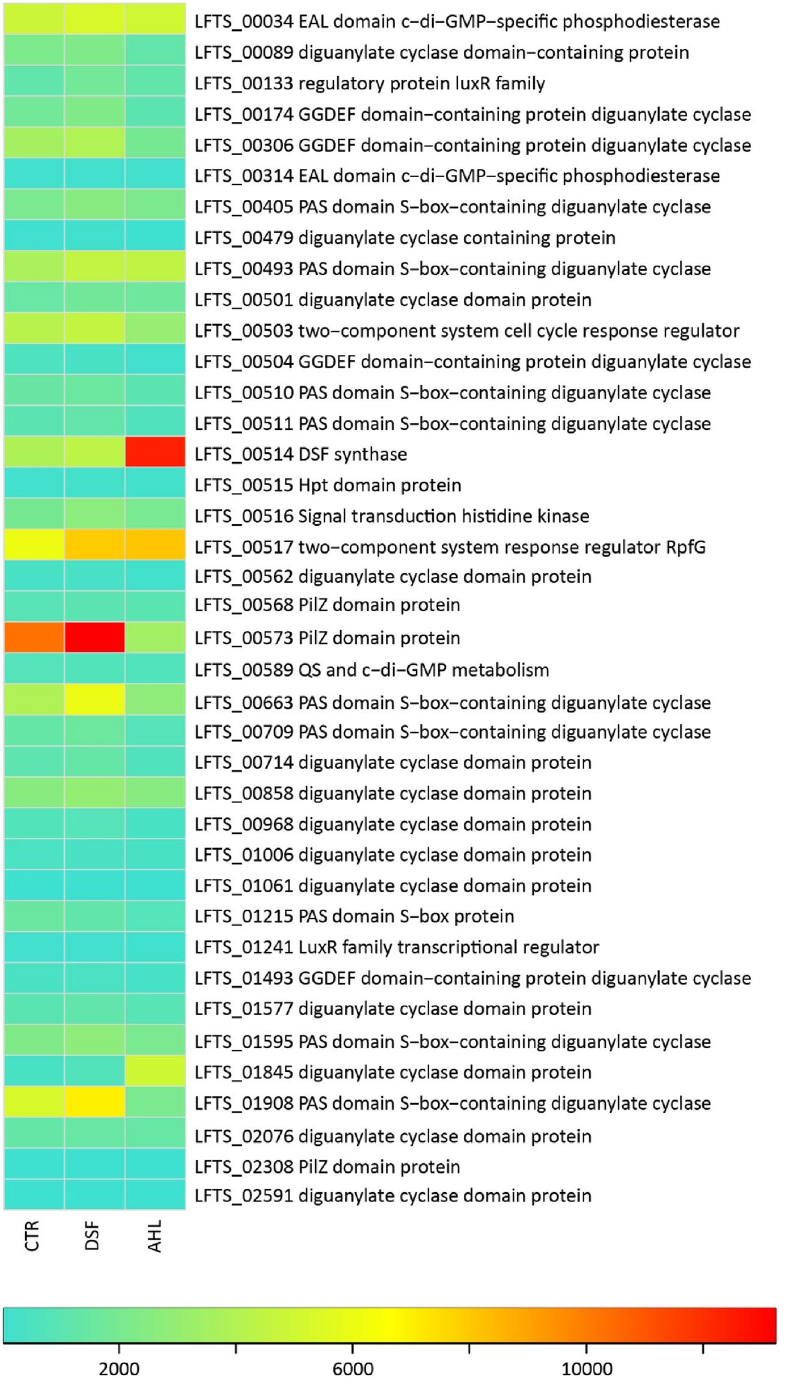
Figure 9. Heatmap of averaged counts of transcripts of QS and c-di-GMP metabolism genes. Color-coded averaged counts of transcripts indicate low (0; turquoise), medium (6500; yellow) and high (13,000; red) counts of gene transcripts in RNA samples from cells exposed to DSF molecules (DSF), N-acyl-homoserine-lactones (AHL) or control cells